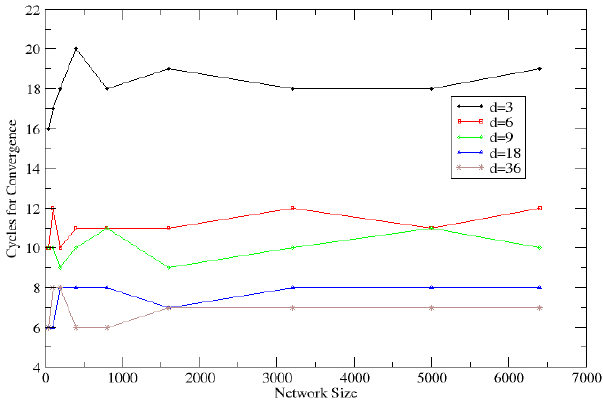
Figure 10. Cycles for convergence of the estimated